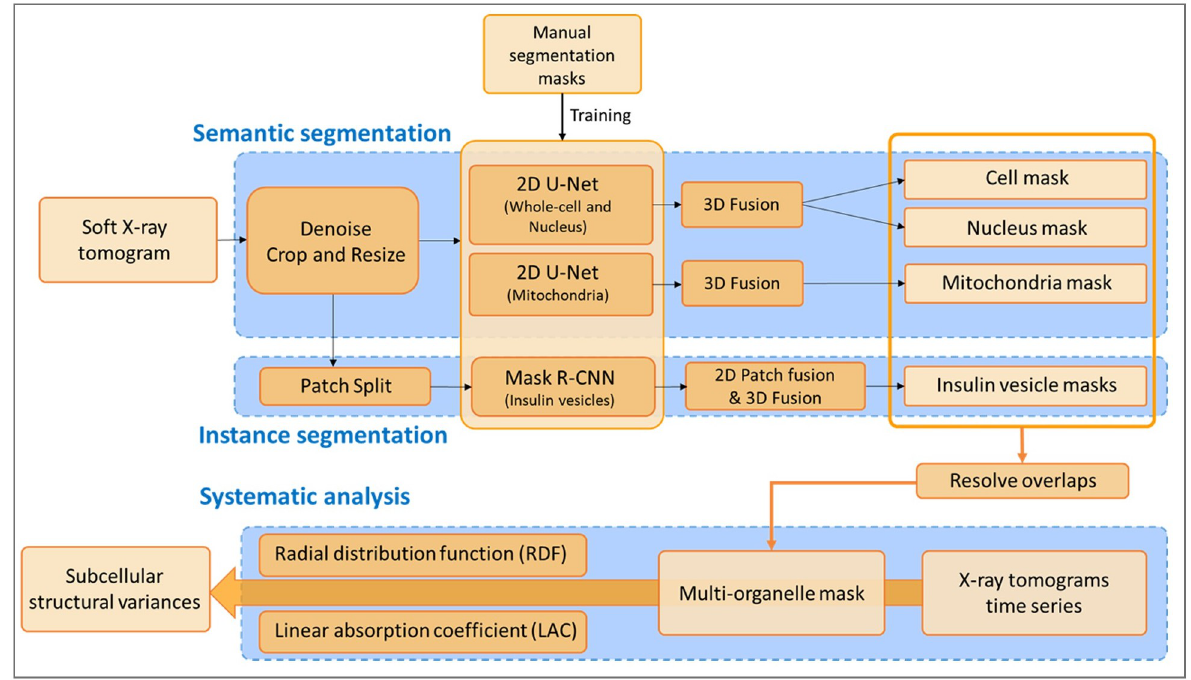
Fig 1. Complete workflow of the segmentation and analysis of time-resolved soft X-ray tomograms (SXT). Blue boxes highlight the three different frameworks: semantic segmentation, instance segmentation, and systematic analysis. Dark orange boxes show the steps of each framework; light orange boxes represent data at different stages; black arrows indicate the direction of data processing; and the thick orange arrow represents multiple and simultaneous tomograms processing. The predicted 2D labels of ‘cell’, ‘nucleus’, ‘mitochondria’ and individual ‘insulin vesicle’ masks were combined to generate 3D organelle masks. Then these 3D masks were merged together based on the priority (Method: Systematic analysis) to get the multi-organelle mask.